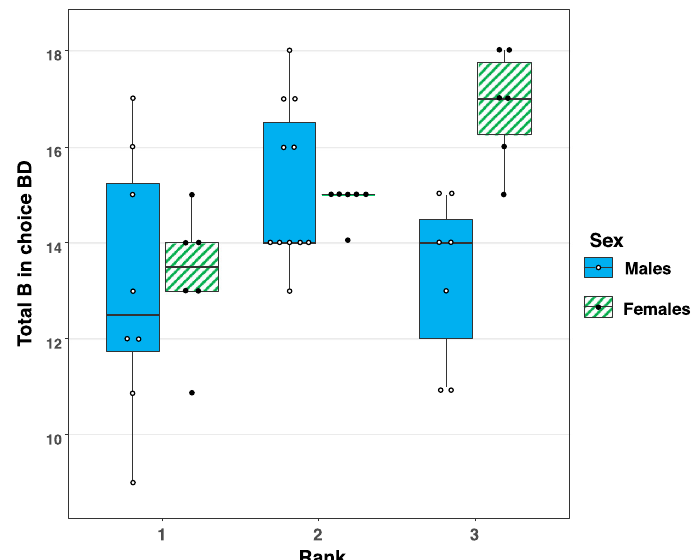
Fig. 1 Choice of B in the comparison BD with respect to rank and to sex (total n = 44, 26 males and 18 females). The box of the boxplot represent the 1st – 3rd quartile of data with the ‘ whiskers ’ showing the maximum and minimum values. Values out with the maximum and minimum are outliers of the data set. Individual data points are shown as